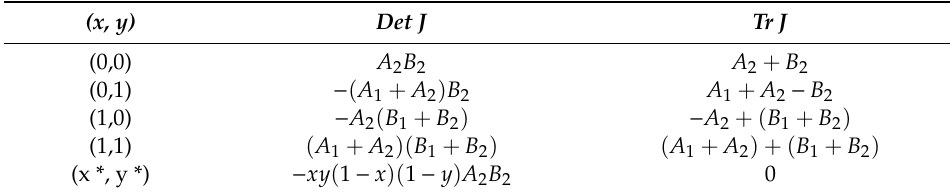
Table 2. Analysis of Equilibrium